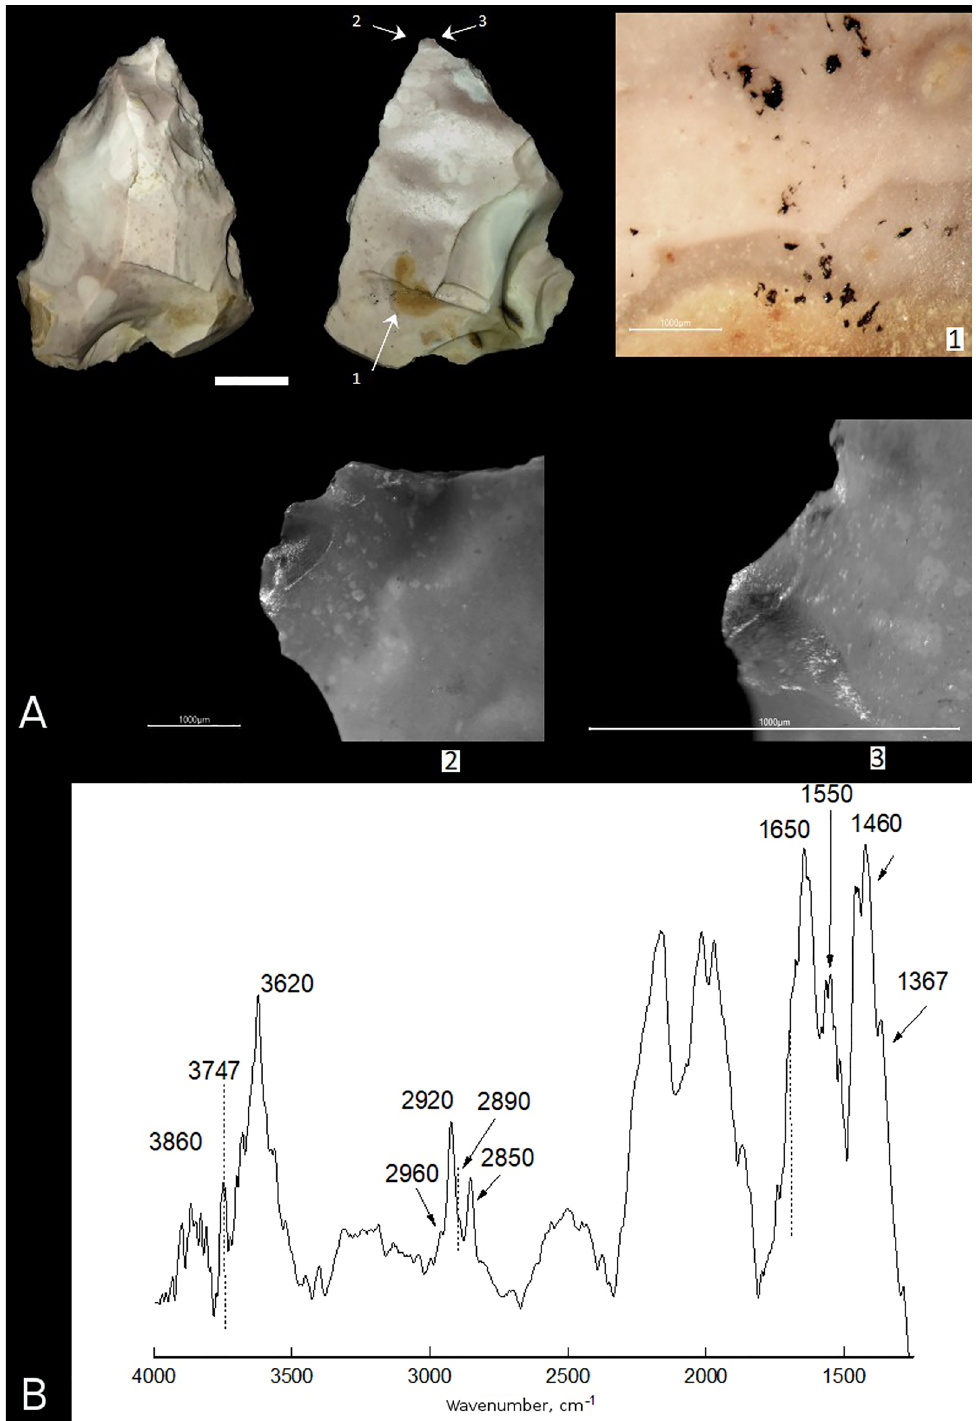
Figure 5. Use-wear and residue analyses of sample 4 found in Layer 6B at Saradj-Chuko grotto. ( A ) Photo of sample 4, scale bar = 1 cm. The arrows indicate position of close-ups of residues and use-wear traces shown on microscopic photos 1–3, scale bar = 1000 μm: (1) residues of black substance (bitumen) on the tool base, (2, 3) (2, 3) polishing and spin-off fractures on the tip. ( B ) FTIR spectrum of the black substance (bitumen residue) found on sample